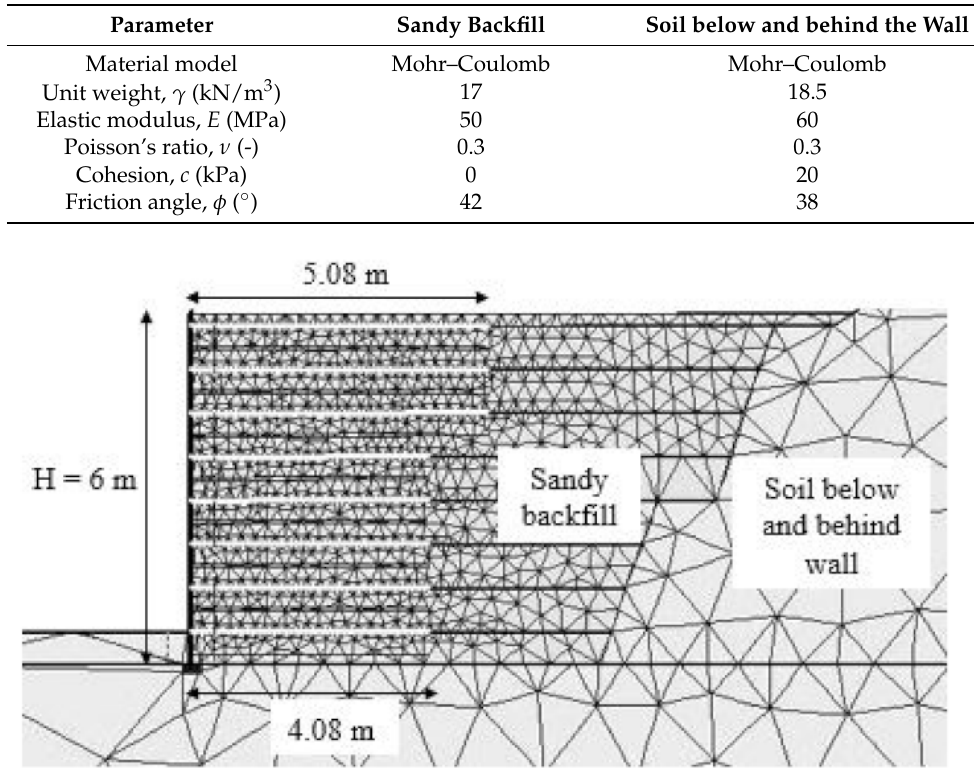
Figure 5. Detail of the FEM model and mesh of experimental wall used for